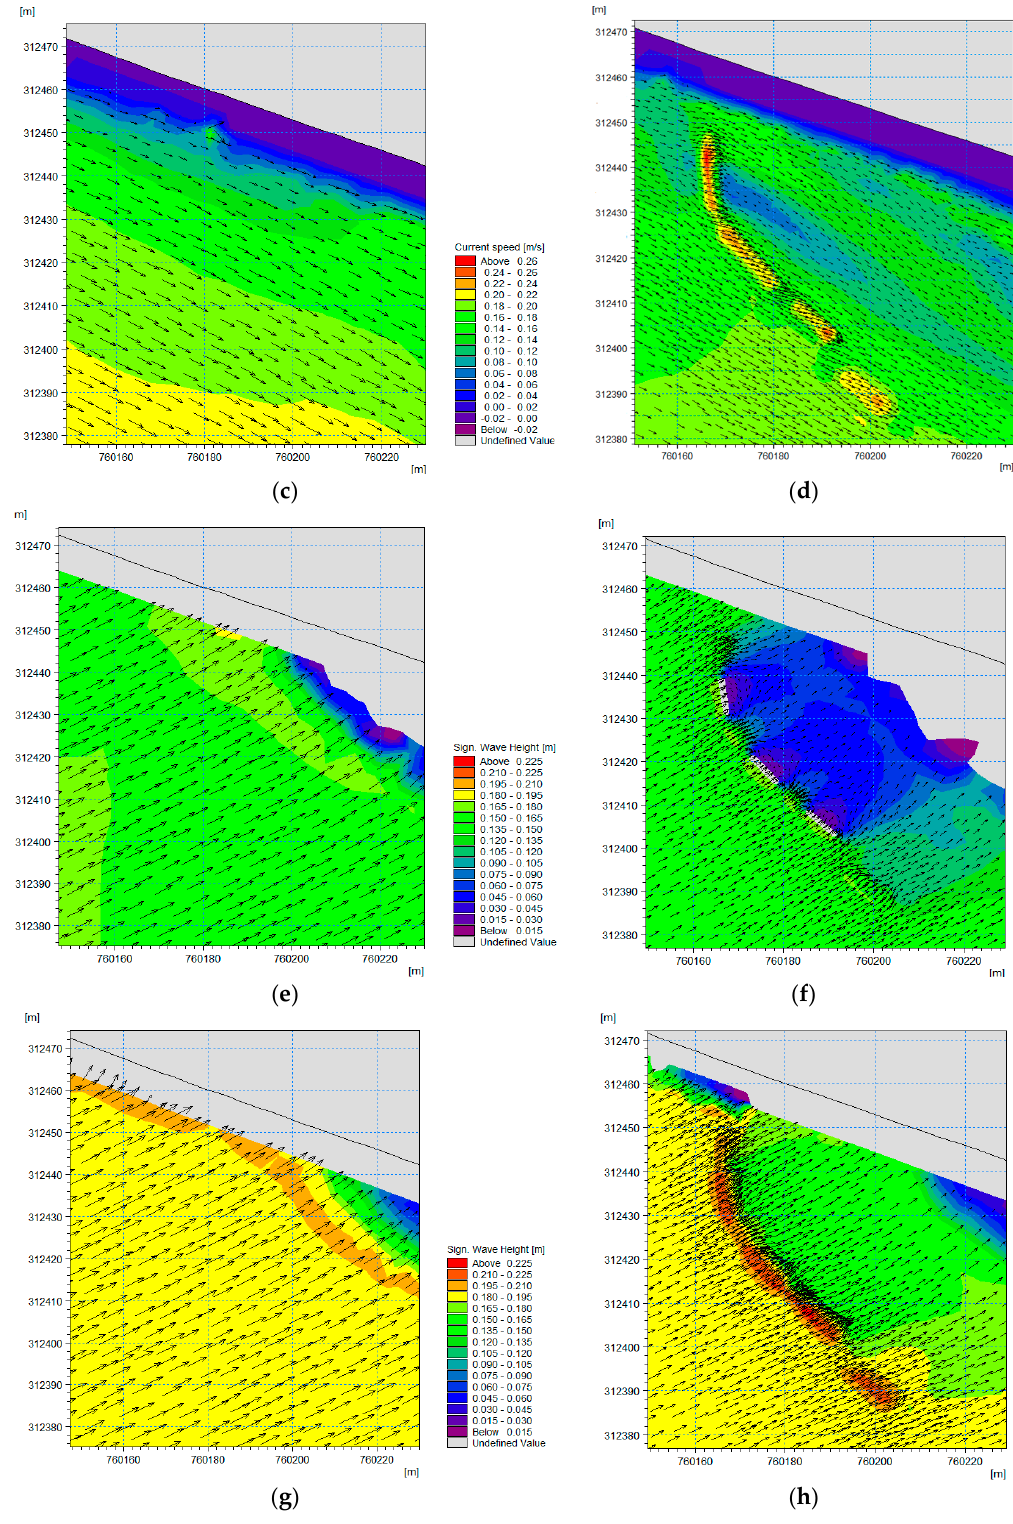
Figure 9. Simulated current and wave characteristics during the Northeast season: ( a ) CS during NT (WT); ( b ) CS during NT (W); ( c ) CS during ST (WT); ( d ) CS during ST (W); ( e ) SWH during NT (WT); ( f ) SWH during NT (W); ( g ) SWH during ST (WT); ( h ) SWH during ST (W). Notes: W = with breakwater, WT = without breakwater, CS = current speed, SWH = significant wave height, NT = neap tide, ST = spring tide.